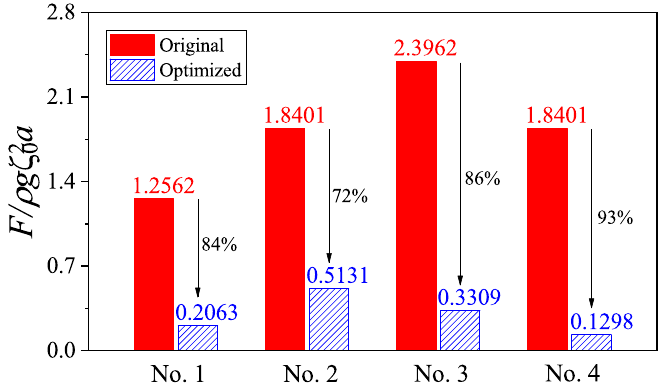
Figure 19. The wave drift forces on each cylinder for the original structure and the optimized structure at k 0 a =